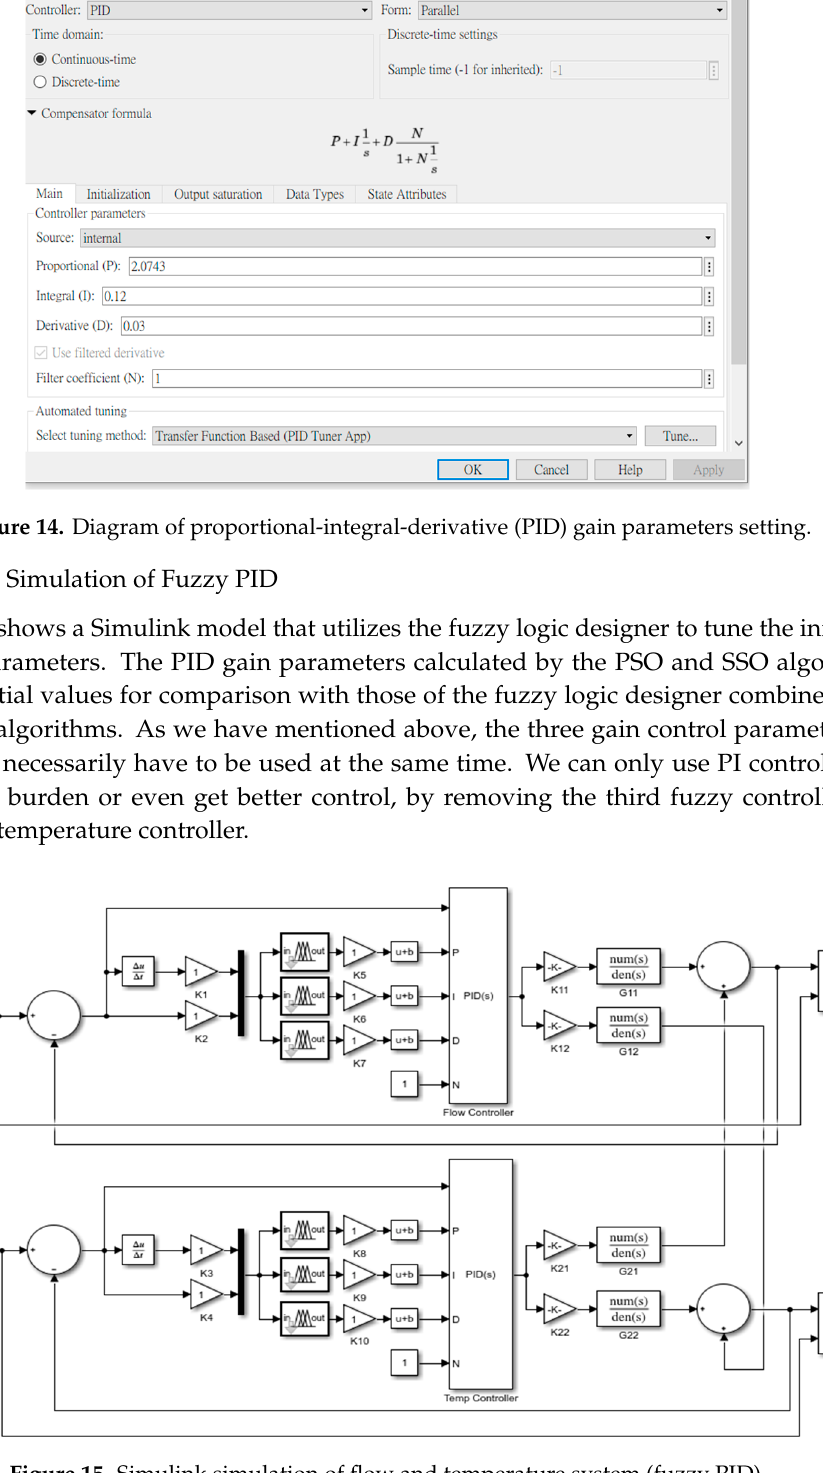
Figure 13. Simulink simulation of flow and temperature system (Z–N, PSO, and SSO).